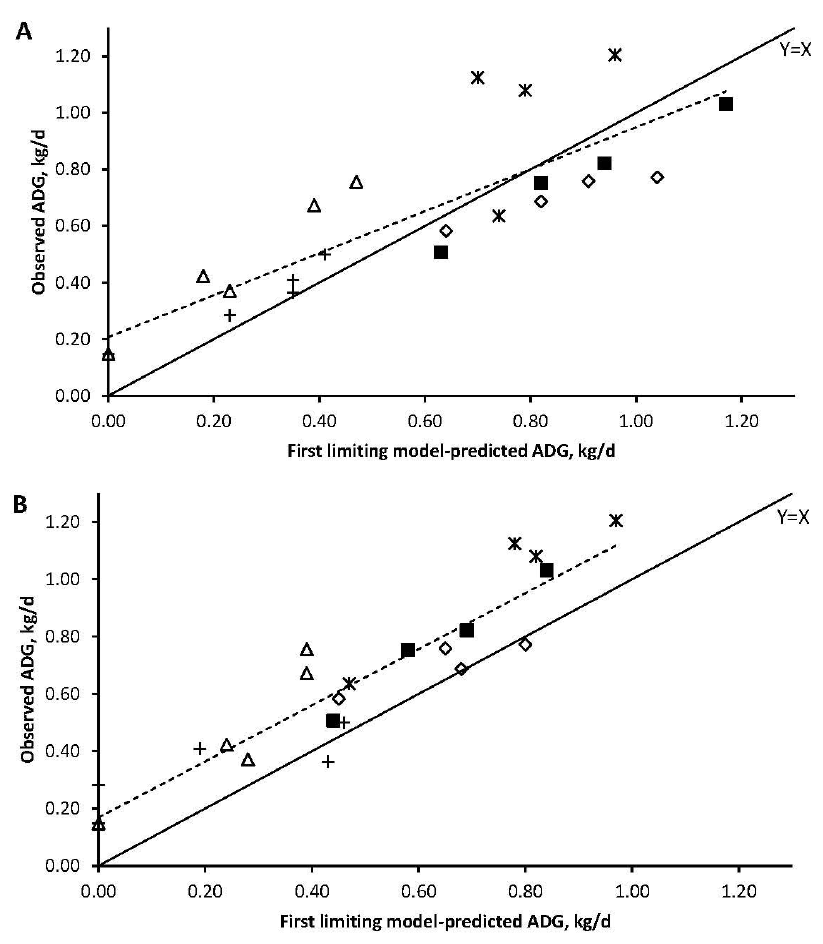
Figure 3. Relationships between observed and first-limiting model-predicted average daily gain (ADG) using level 1 (A) or level 2 (B) solutions of the Large Ruminant Nutrition System. Symbols are studies 1 (  ), 2 (■), 3 (  ), 4 (+), and 5 (  ). Solid line is the Y = X and the dotted line is the linear